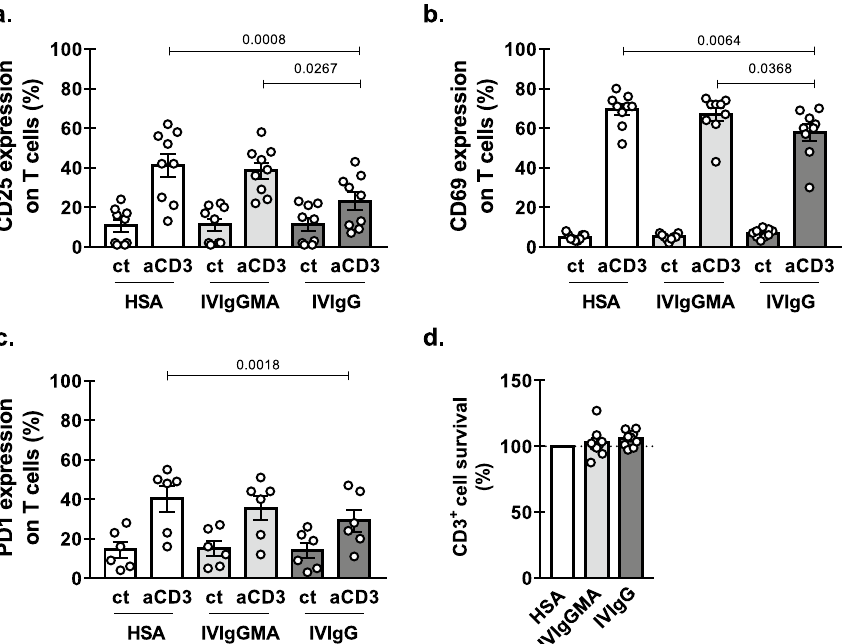
Figure 1. Effect of IVIg preparations on T cell activation. PBMC from CLL patients were cultured in the presence of IVIgGMA, IVIgG (10 mg/mL of IgG) or HSA at equimolar concentration (control), in